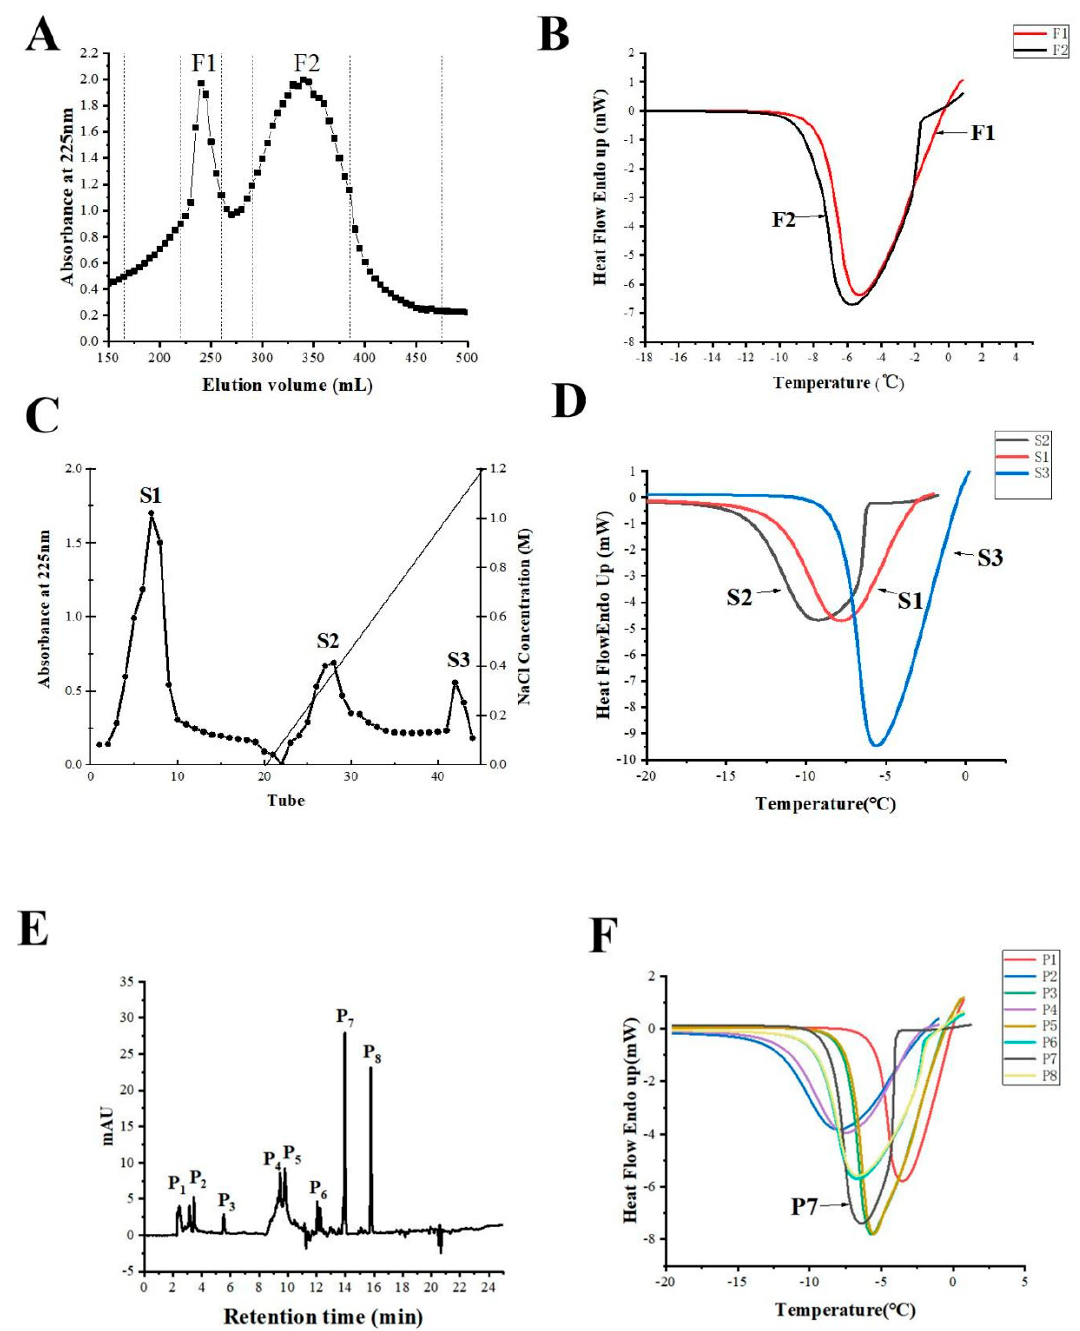
Figure 3. The elution and DSC curves of the AFPs. ( A ) The Sephadex G-50 gel elution profiles of the hydrolysates. ( B ) The corresponding DSC curves of the fractions (F1–F2). ( C ) The SP-Sephadex C-25 strong cation exchange F2 elution profiles. ( D ) The DSC curves of the fractions (S1–S3) eluted from the same column as ( C ). ( E ) The elution profile of the S2 fraction on a C18 column. ( F ) The DSC curves of fractions (P1, P2, P3, P4, P5, P6, P7, P8) eluted from C18 column. The data points represent the mean values calculated from two separate experiments. Table 2. The purification folds of GCFSC-AFPs from the Ctenopharyngodon idella scales.